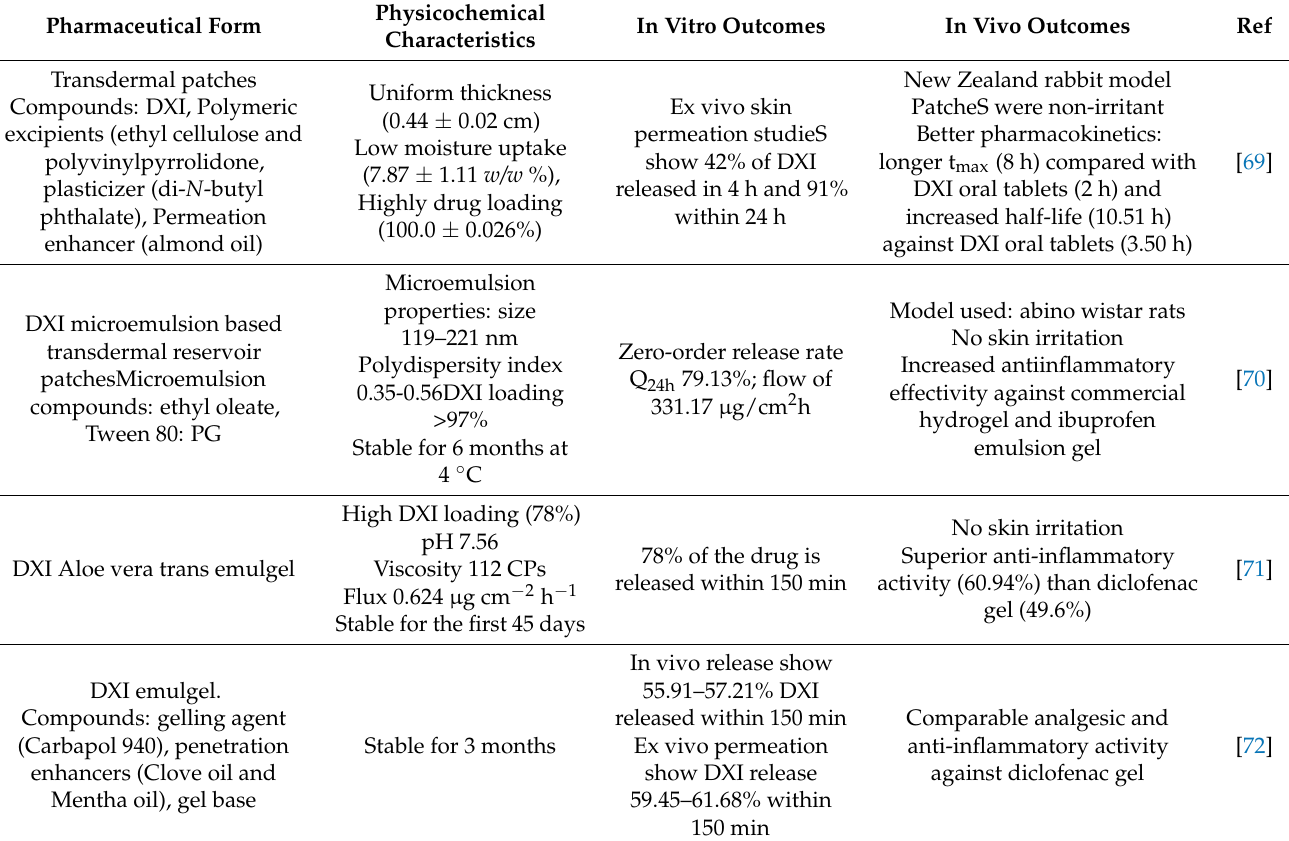
Table 1. Skin applied dexibuprofen (DXI) drug delivery